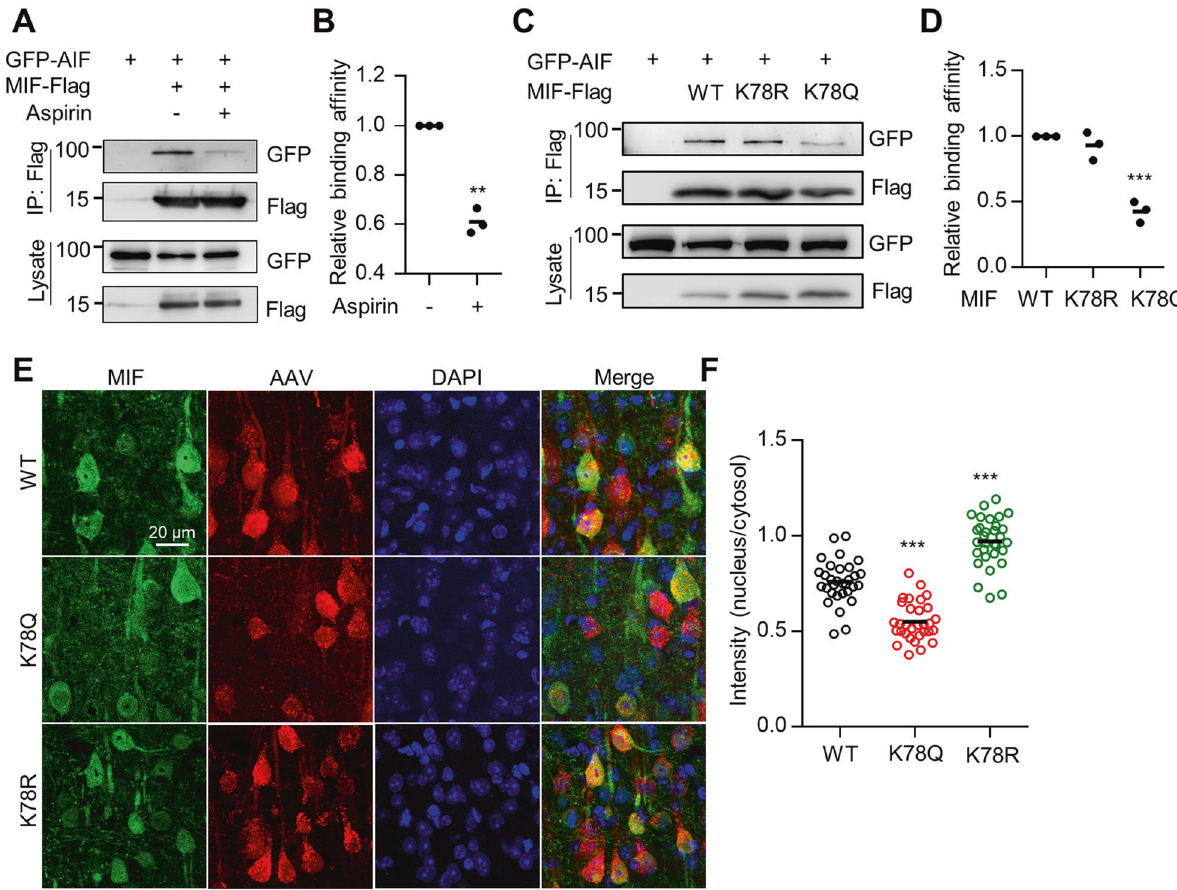
Fig. 3 MIF K78 acetylation impaired MIF interaction with AIF and nuclear translocation. A Reduced interaction between MIF and AIF after aspirin treatment. HEK293T cells were transfected with GFP-AIF and MIF-Flag. MIF protein was immunoprecipitated with anti-Flag antibody and the resulting complex was probed with anti-GFP antibody. B Quanti fi cation of AIF interaction with MIF shown in ( A ). Data shown were independent points and mean; n = 3; paired t -test; ** p < 0.01. C Acetylation of MIF K78 impaired binding to AIF. HEK293T cells were transfected with MIF-Flag, K78R-Flag, K78Q-Flag, and GFP-AIF. MIF protein was immunoprecipitated with an anti-Flag antibody, and the resulting complex was probed with an anti-GFP antibody. D Quanti fi cation of AIF interaction with MIF shown in ( C ). Data shown were independent points and mean; one-way ANOVA; n = 3; *** p < 0.001. E Acetylation of MIF K78 impaired MIF translocation to the nucleus after ischemia. AAV-MIF-2A-mCherry, AAV-K78Q-2A-mCherry, and AAV-K78R-2A-mCherry were injected into the cortex and ischemia was induced. Brain sections were stained with anti-MIF antibody (green). F Quanti fi cation analysis of MIF intensity in the nucleus/cytosol. Data shown were mean ± SEM; one-way ANOVA; n = 16 cells were randomly selected from three mice; *** p <